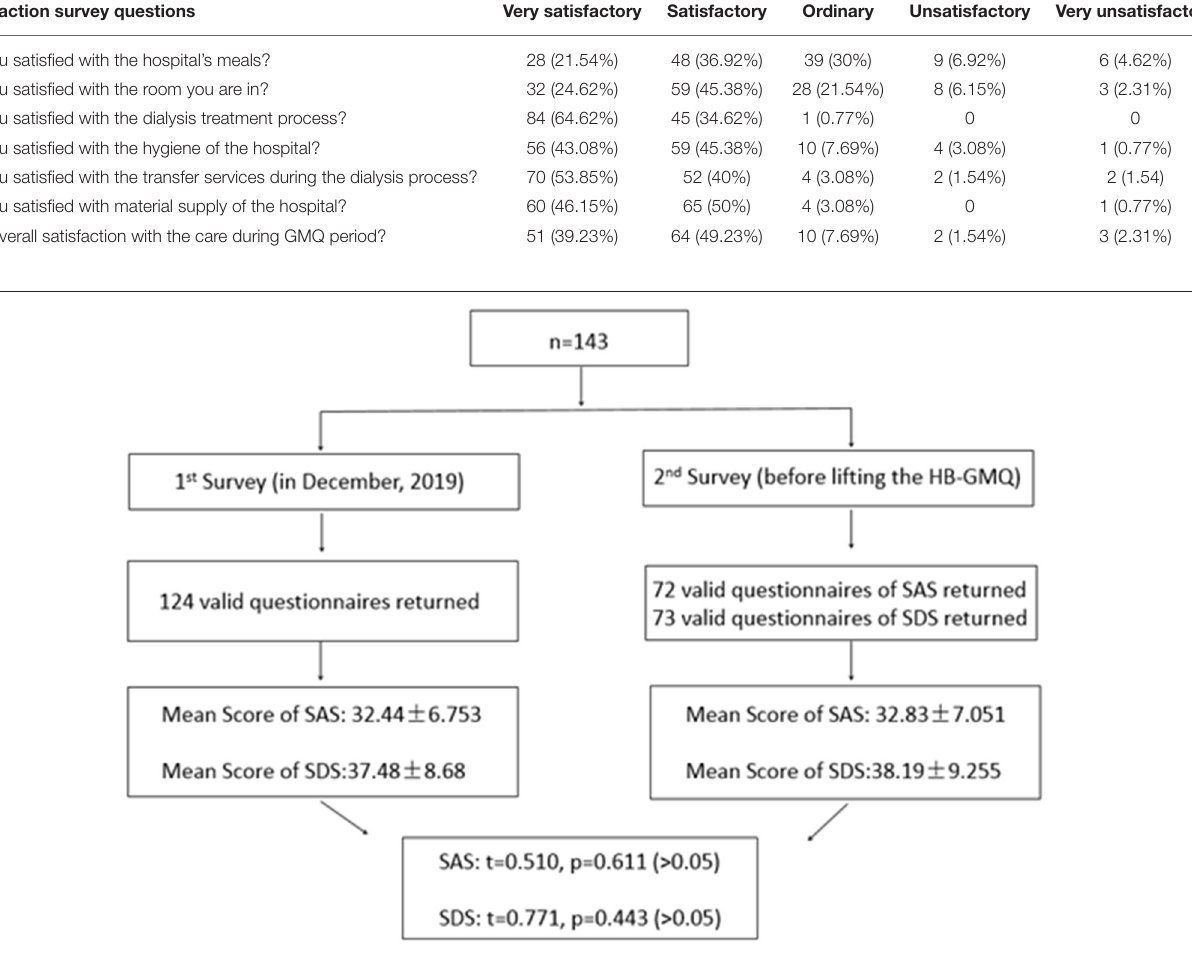
FIGURE 2 | SAS and SDS scores of study